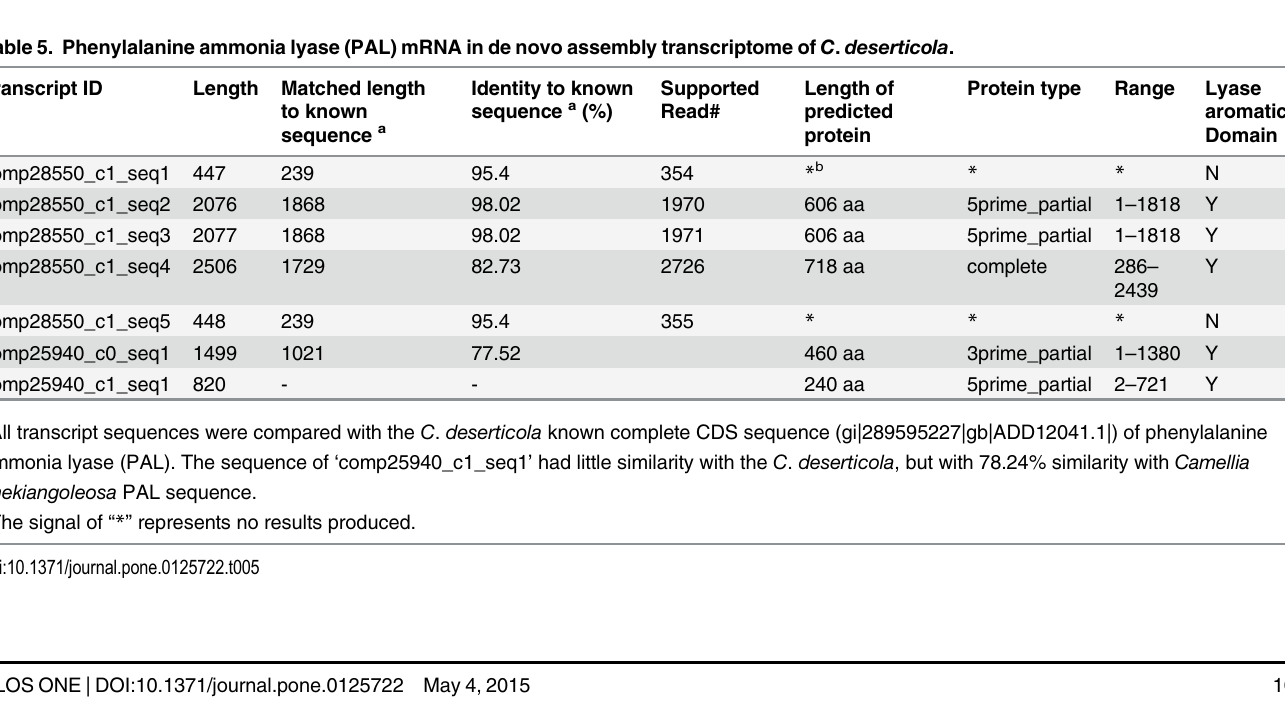
Fig). 4-coumarate-CoA ligase (4CL, EC 6.2.1.12) and trans-cinnamate 4-monooxygenase (CYP73A, EC 1.14.13.11) are two enzymes responsible for transforming cinnamic acid to p- coumaroyl-CoA in two reverse orders. They are also in backbones, and their expression FPKM values are 39.57 and 51.93, respectively.